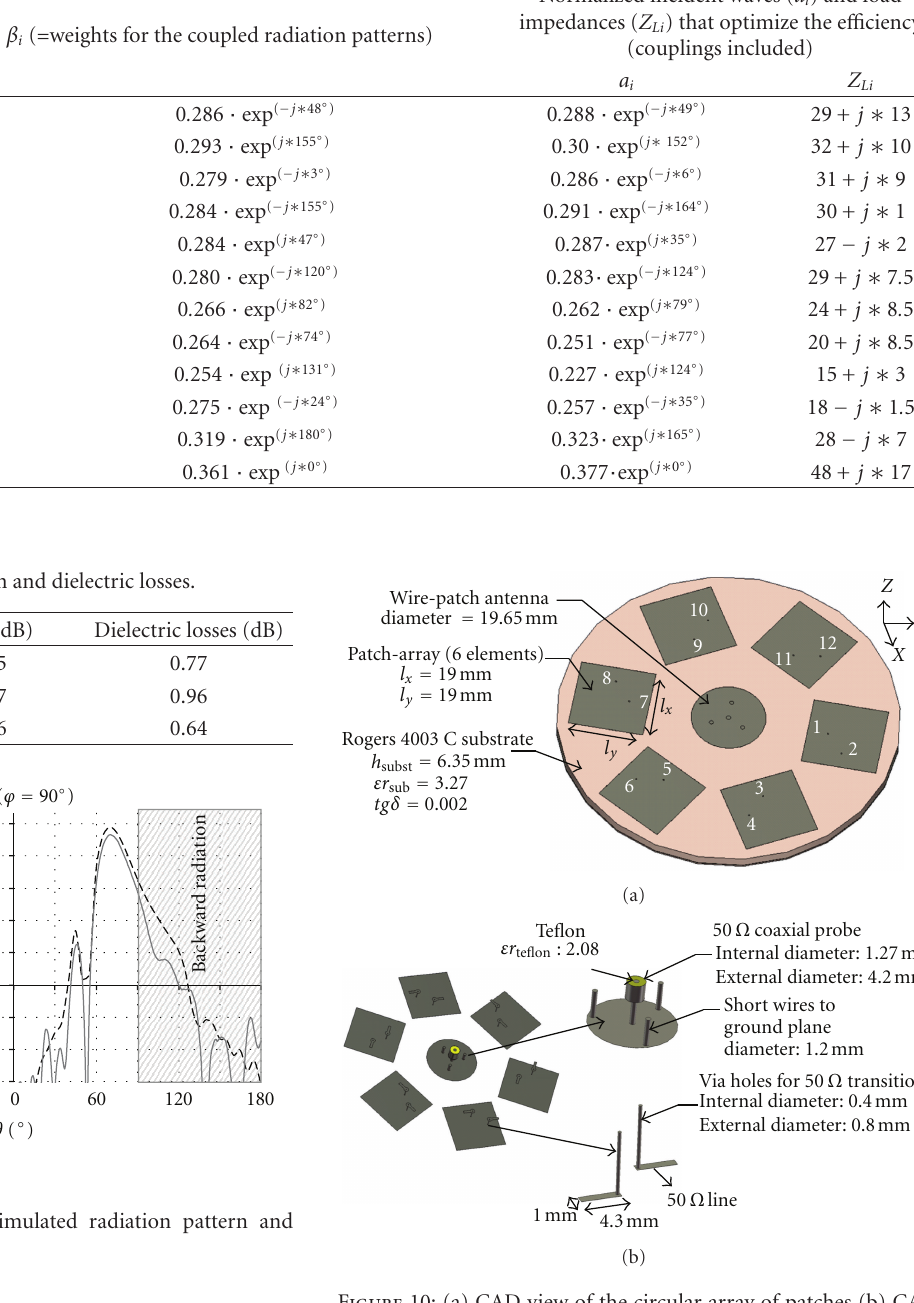
Figure 10: (a) CAD view of the circular array of patches (b) CAD view of the transitions through the feed distribution